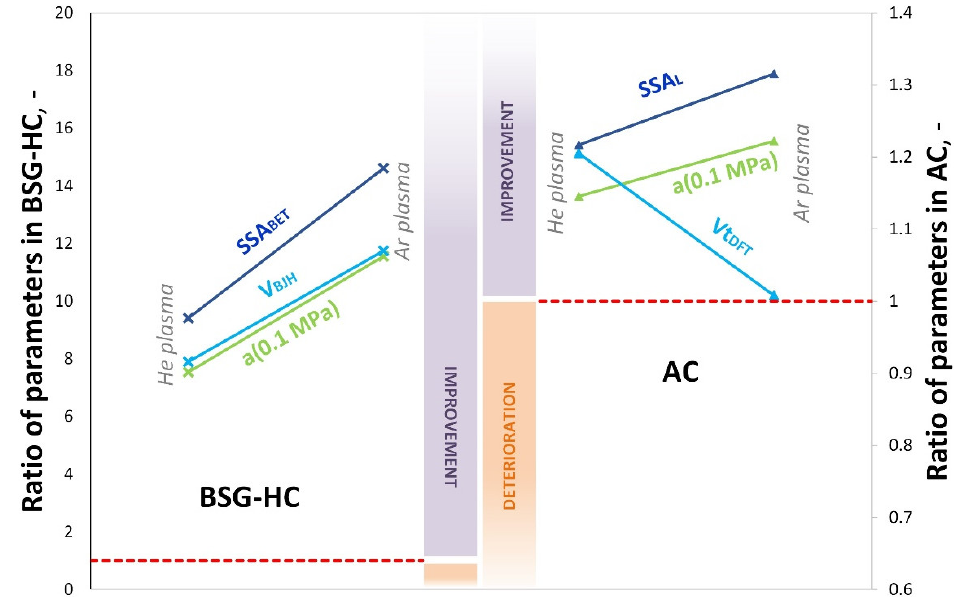
Figure 7. Relationship diagram of the structural parameters in BSG-HC and AC.